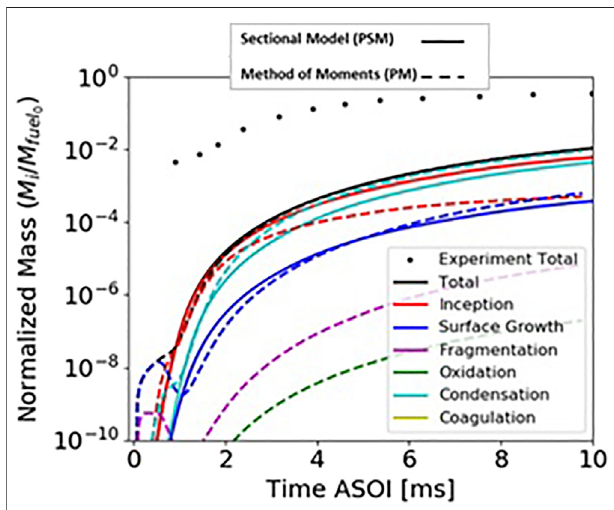
FIGURE 7 | Cumulative soot mass normalized by mass of injected fuel versus time ASOI with contributions from different sub-models for the PSM andPMsootmodelswiththedetailedkineticmechanismof(Kukkadapuetal.,